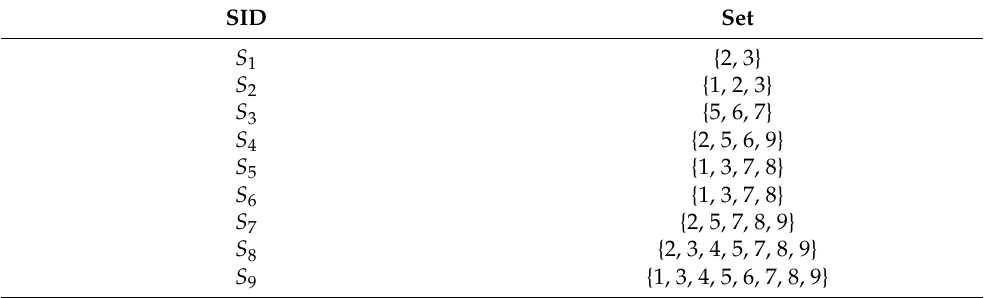
Table 1. An example dataset.